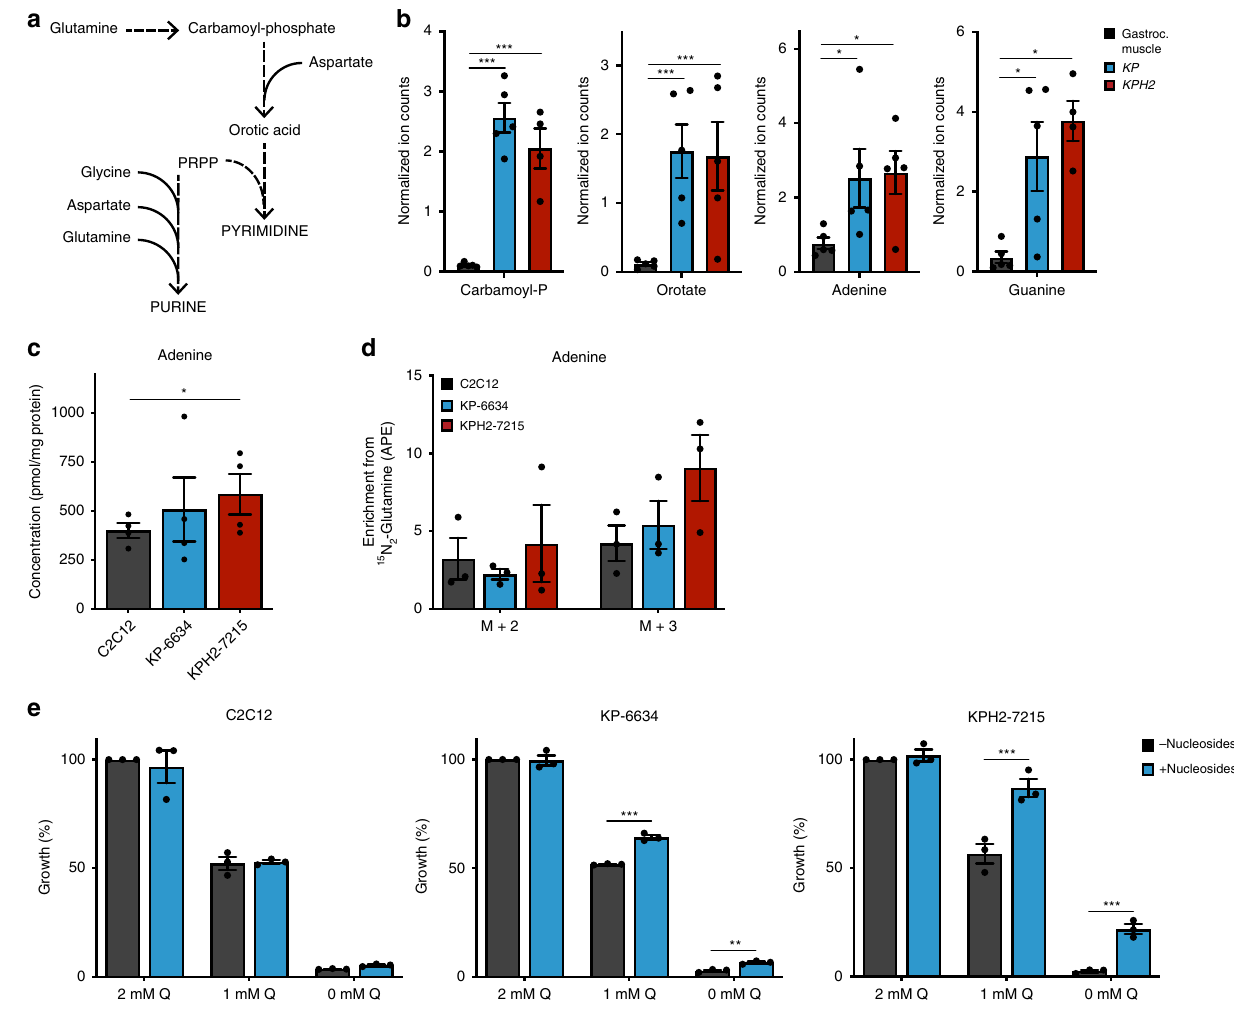
Fig. 3 Glutamine anaplerosis promotes nucleoside production in UPS tumour cells. a Schematic depicting purine and pyrimidine biosynthesis. b Normalized ion counts for carbamoyl phosphate (carbamoyl-P), orotate, adenine, and guanine (left to right) in gastrocnemius muscle (gastroc. muscle), KP , and KPH2 tumours. N = 4 with three technical replicates. Data represent mean ± s.d.; * p < 0.05, *** p < 0.0005. c Concentration of total adenine levels in C2C12s, KP-6634s, and KPH2-7215s. N = 3 with two technical replicates. Data represent mean ± s.e.m.; * p < 0.05. d Mass isotopomer analysis of M + 2 and M + 3 enrichment in adenine, represented as atoms percent excess (APE), in C2C12s, KP-6634s, and KPH2-7215s cultured for 5 h with 15 N 2 - glutamine. N = 3 with two technical replicates. Data represent mean ± s.e.m. e Growth of C2C12s, KP-6634s, and KPH2-7215s (left to right) grown in media with 0 – 2 mM glutamine (Q) and supplemented with 50 μ M adenosine, guanosine, cytidine, and thymidine (Nucleosides) for 72 h. N = 3 with three technical replicates. Data represent mean ± s.e.m.; ** p < 0.005, *** p < 0.0005. p -Values were calculated from a two-tailed Student ’ s t -test for b – e . Source data are provided as a Source Data fi